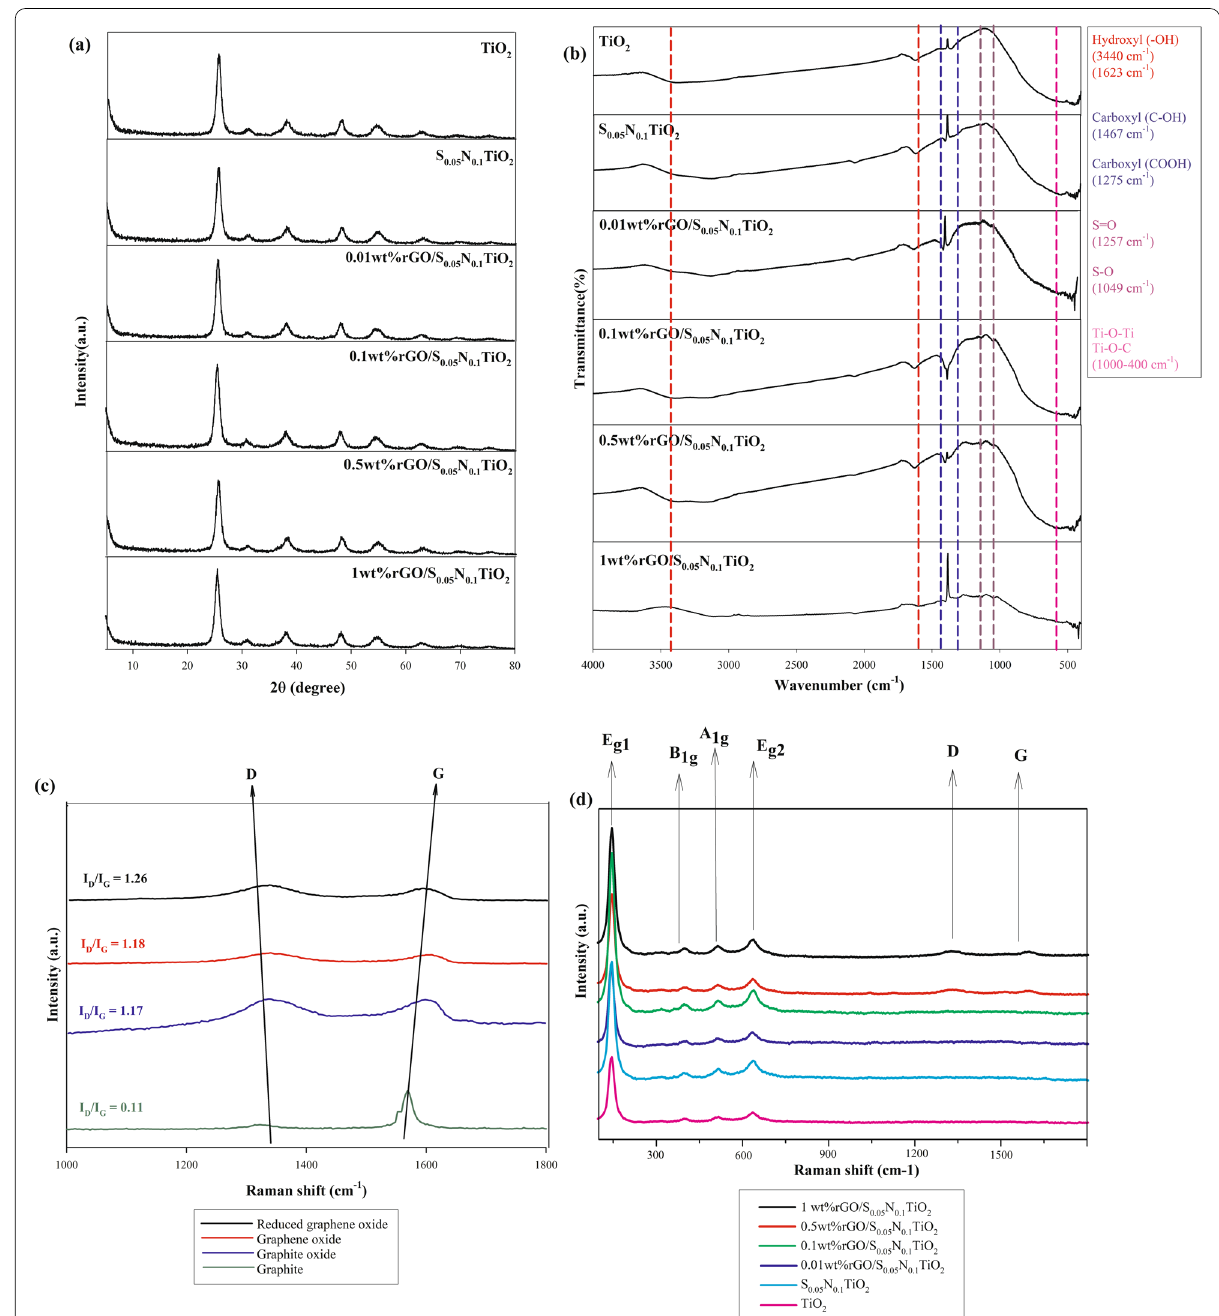
Fig. 1 ( a ) XRD patterns, ( b ) FTIR spectra, and ( c ) Raman spectra of various synthesized